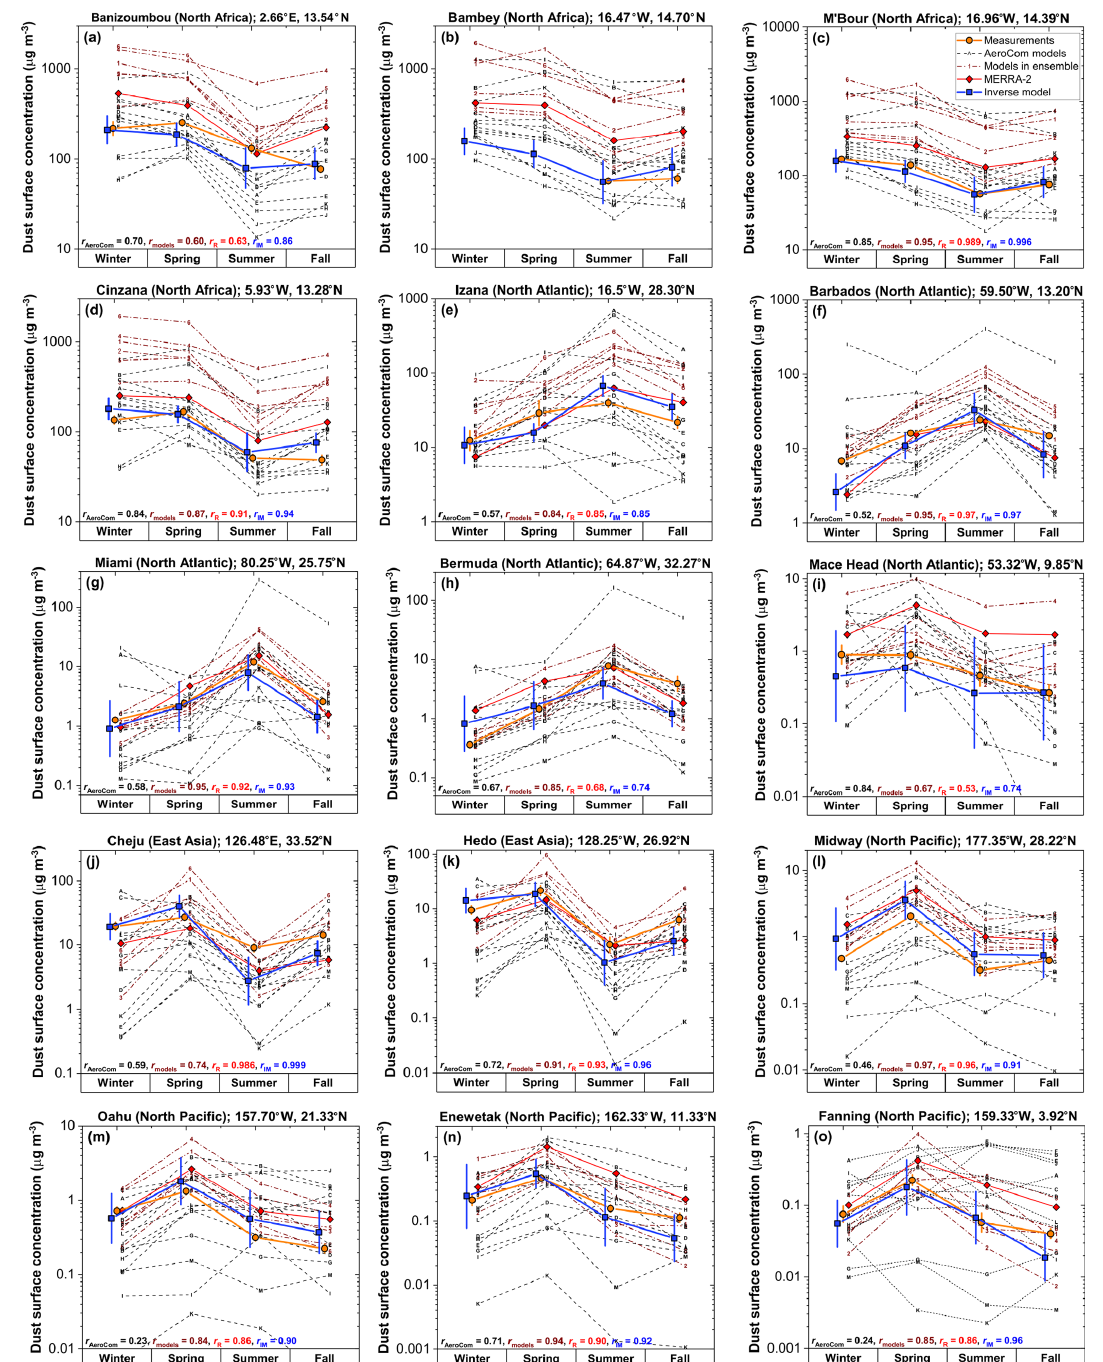
Figure 6. Comparison of measured and modeled seasonally averaged dust surface concentrations at 15 Northern Hemisphere stations. The inverse model results (blue line and squares) capture the measured seasonal variability (orange line and circles) at all stations, with lower error (see Fig. 8c) and on average higher correlation coefficients than MERRA-2 (red line and diamonds), models in the AeroCom ensemble (black dotted lines and letters), and (unmodified) models in our ensemble (brown dashed lines and numbers). Also shown are the mean correlation coefficients between measurements and the different AeroCom models ( r AeroCom ) and between measurements and the different models in our ensemble ( r models ), as well as the correlation coefficients for MERRA-2 ( r R ) and the inverse model results ( r IM ). Uncertainty ranges for measurements and the inverse model results represent 1 standard error in the climatological seasonally averaged surface concentration. The legend for individual models is given in Fig. 3, and x values are slightly offset for